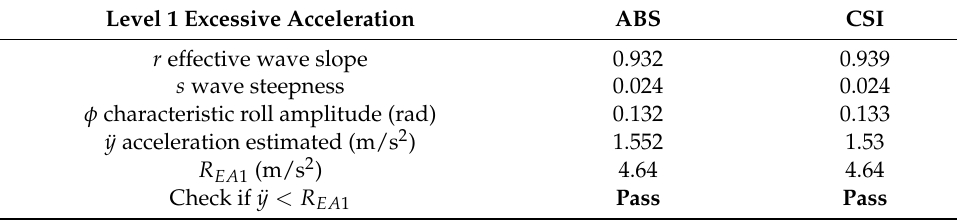
Table 28. Level 1 assessment of the excessive acceleration failure mode for KCS container ship.